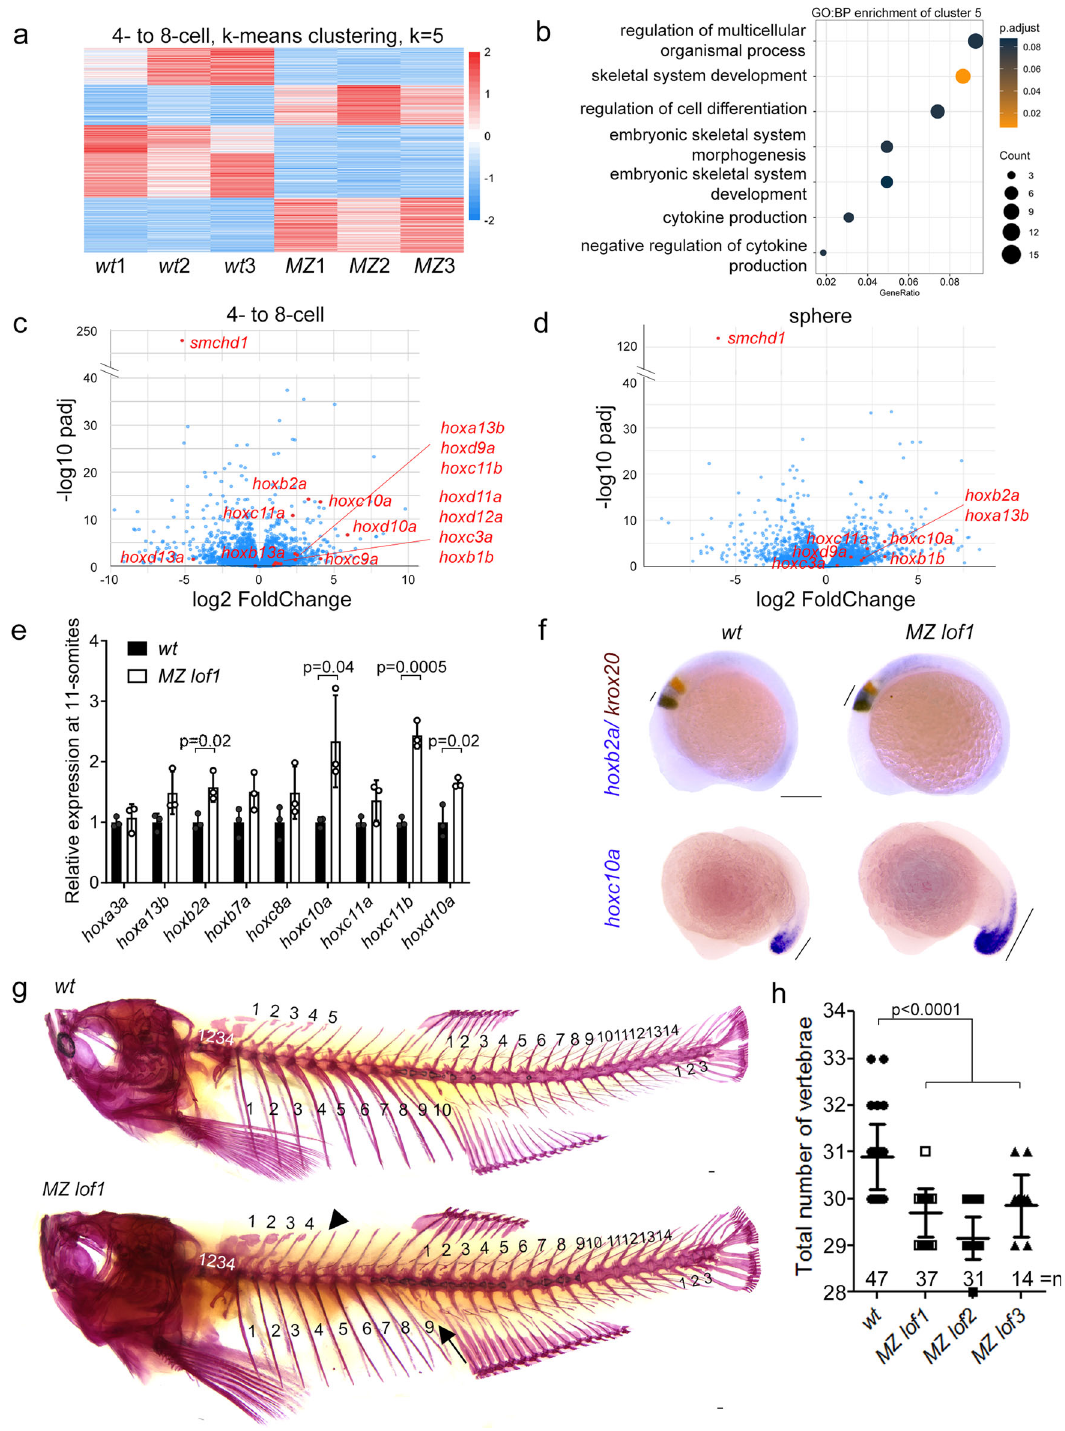
Fig. 2 MZ smchd1 fi sh embryos show derepression of hox genes and vertebral patterning defects. a K-means clustering of differentially expressed genes at 4-8-cell stage. b Gene ontology: biological process (GO:BP) enrichment of cluster 5 from K-means clustering at 4-8-cell stage. RNA-seq of wt and MZ lof1 embryos show changes in hox gene expression at both 4-8-cell stage ( c ) and sphere stage ( d ). e hox genes show persistent upregulation at 11-somites. n = 3 biological samples, p values were calculated by 2-tailed unpaired Student ’ s t test. f hoxb2a shows expanded expression boundary at 10-somites (top) and hoxc10a shows anteriorly expanded expression at 17-somites (bottom). krox20 marks rhombomeres 3 and 5. g – h Adult fi sh show defects in axial skeletal patterning, including loss of a rib (arrow) and loss of a supraneural vertebra (arrowhead). Scale bar = 200 µ m. P values were calculated by the Kruskal-Wallis test followed by Dunn ’ s Multiple Comparison Test. Bars without p values are not signi fi cant. All data are presented as mean values ± SD.